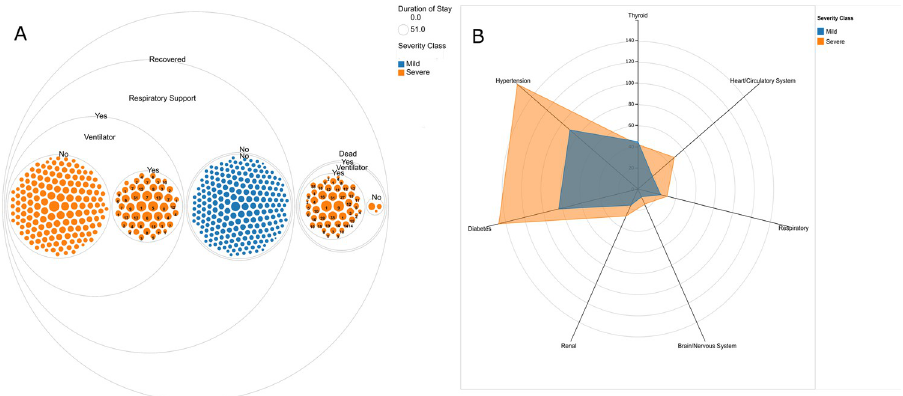
Fig 2. Clinical sub-phenotypes and the co-morbidity feature diversity. (A) Clinical sub-phenotype diversity of the COVID-19 patients. The patients are grouped into Recovered and Dead. Each circle represents individual patients; the color of the circle indicates the severity of the patients whereas the size of the circle represents duration of hospital stay. The numbers on the circle represents the duration in ICU. (B ) Presence of different co-morbid conditions in mild and severe patients. It represents a comparative view of the co-morbidities, patients with mild severity are represented by blue color, while ones with severe COVID-19 infection are represented by